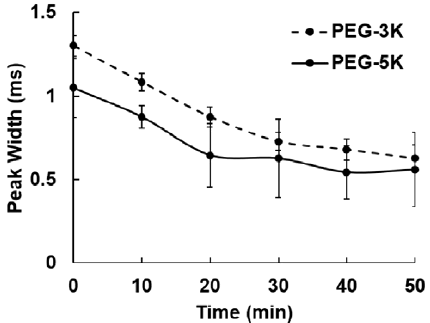
Fig. 10. In vivo monitoring of nanoparticle concentration by IVFC validated by HPLC. (a) Nanoparticle concentration in blood circulation measured by IVFC ð n ¼ 3 Þ . (b) Nanoparticle concentration in blood samples drawn at various time points was measured by HPLC in vitro ( n ¼ 3). The error bars rep- resent standard error of the mean. A.U., arbitrary unit.